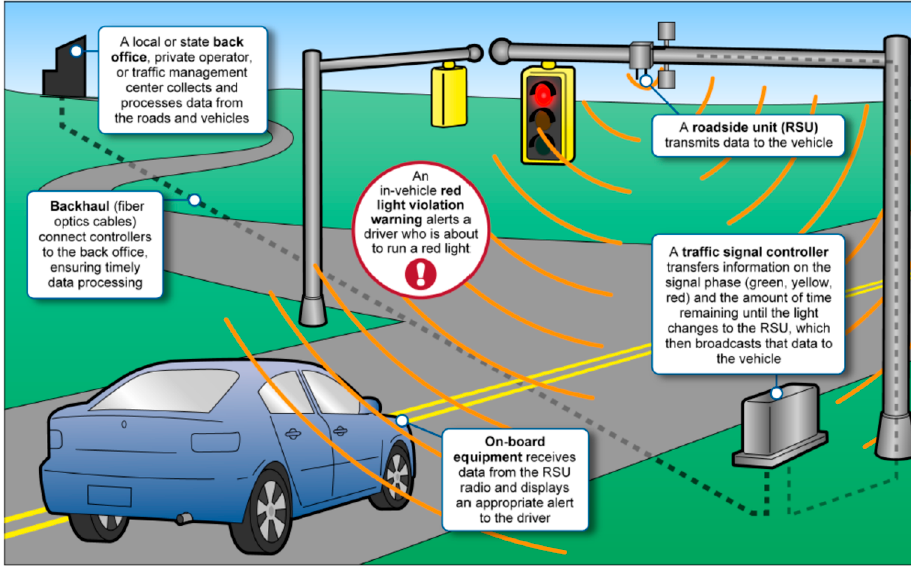
Figure 3. An illustration of the Vehicle-to-Infrastructure (V2I) operation [13].